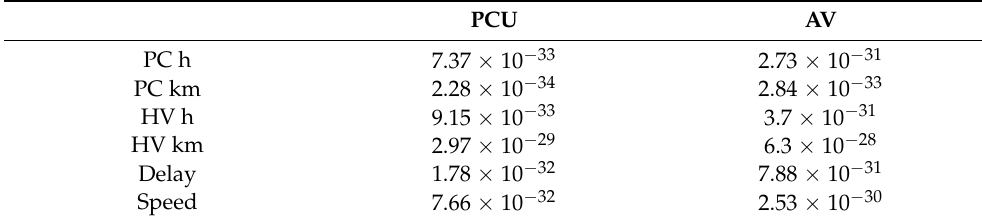
Table 2. p -values associated with each parameter of the six statistical